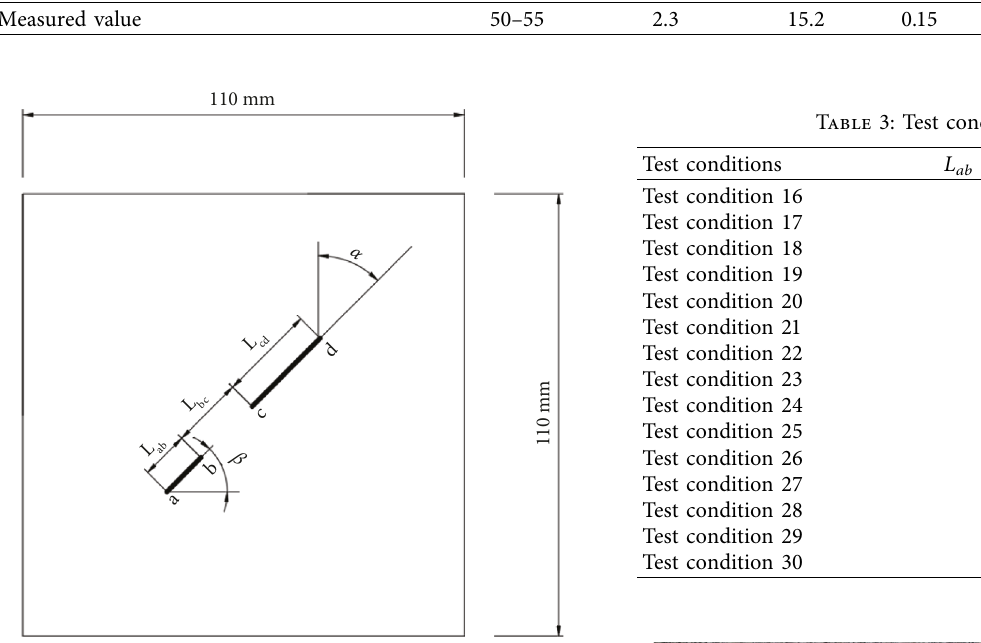
Figure 2: The specimen with two cracks. Table 2: Test condition A .